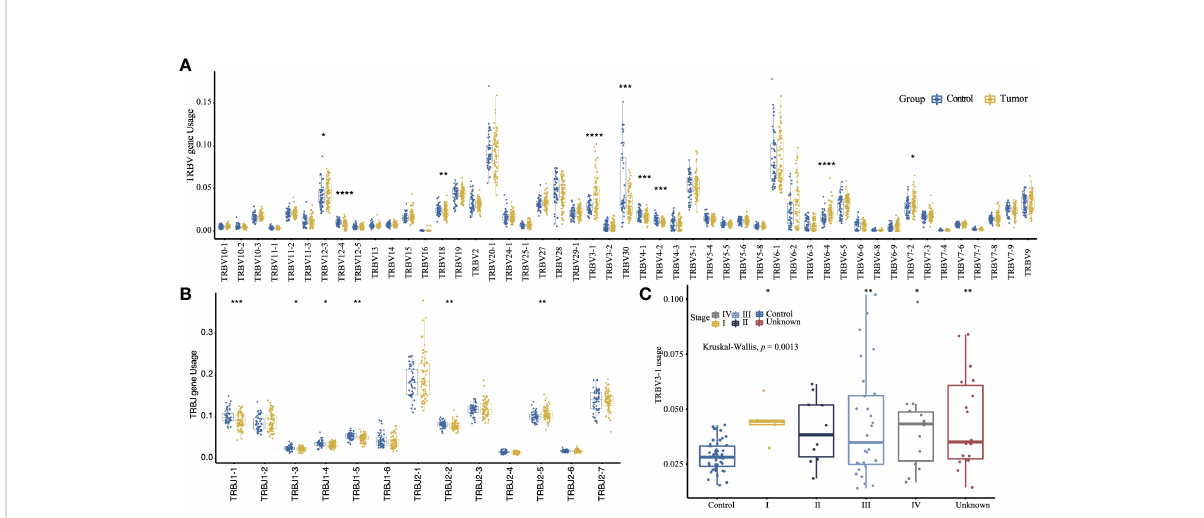
FIGURE 2 The TRBV (A) and TRBJ (B) usage comparison between the tumor group and control group (two-sided t -test). (C) Comparison of TRBV3-1 gene usage between the control group and the sub-tumor group of different tumor stage. (The convention for symbols indicating statistical signi fi cance, ns: p > 0.05; * p ≤ 0.05; ** p ≤ 0.01; *** p ≤ 0.001; **** p ≤ 0.0001; Kruskal – Wallis